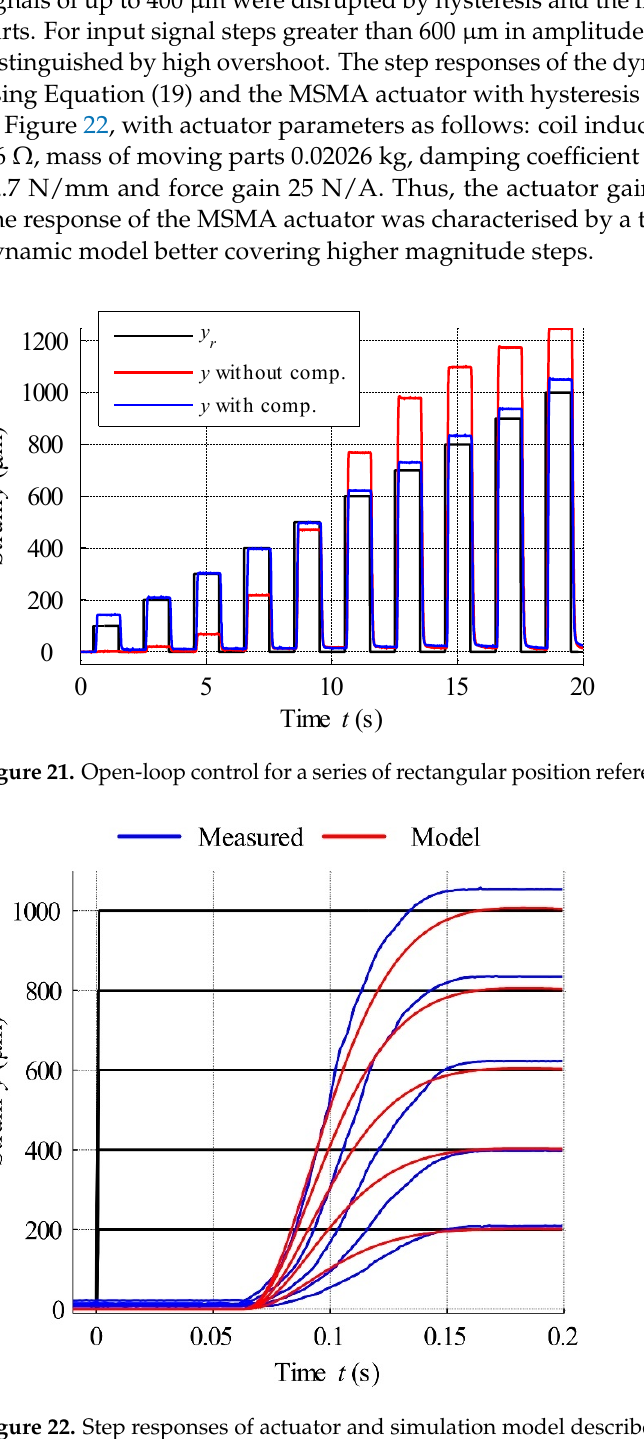
Figure 23. Block diagram of closed-loop control system with direct hysteresis compensation by the inverse model. Table 5. PID controller gains. Controller